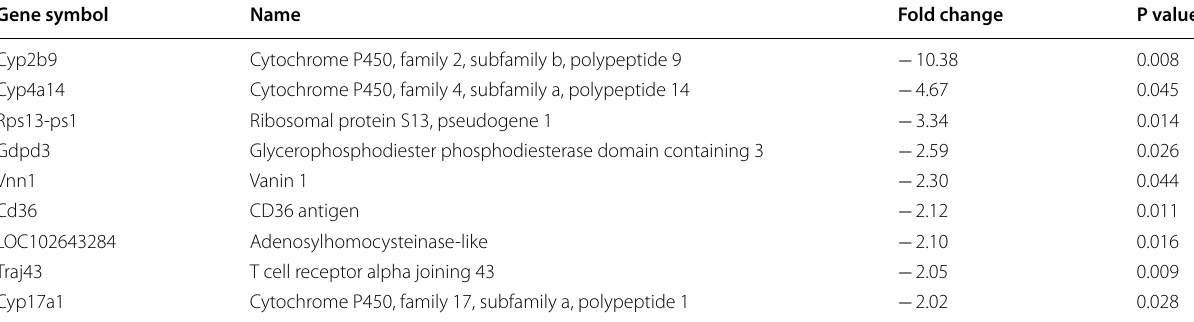
Table 1 Top downregulated genes in liver of miR-100 overexpressing mice Gene symbol